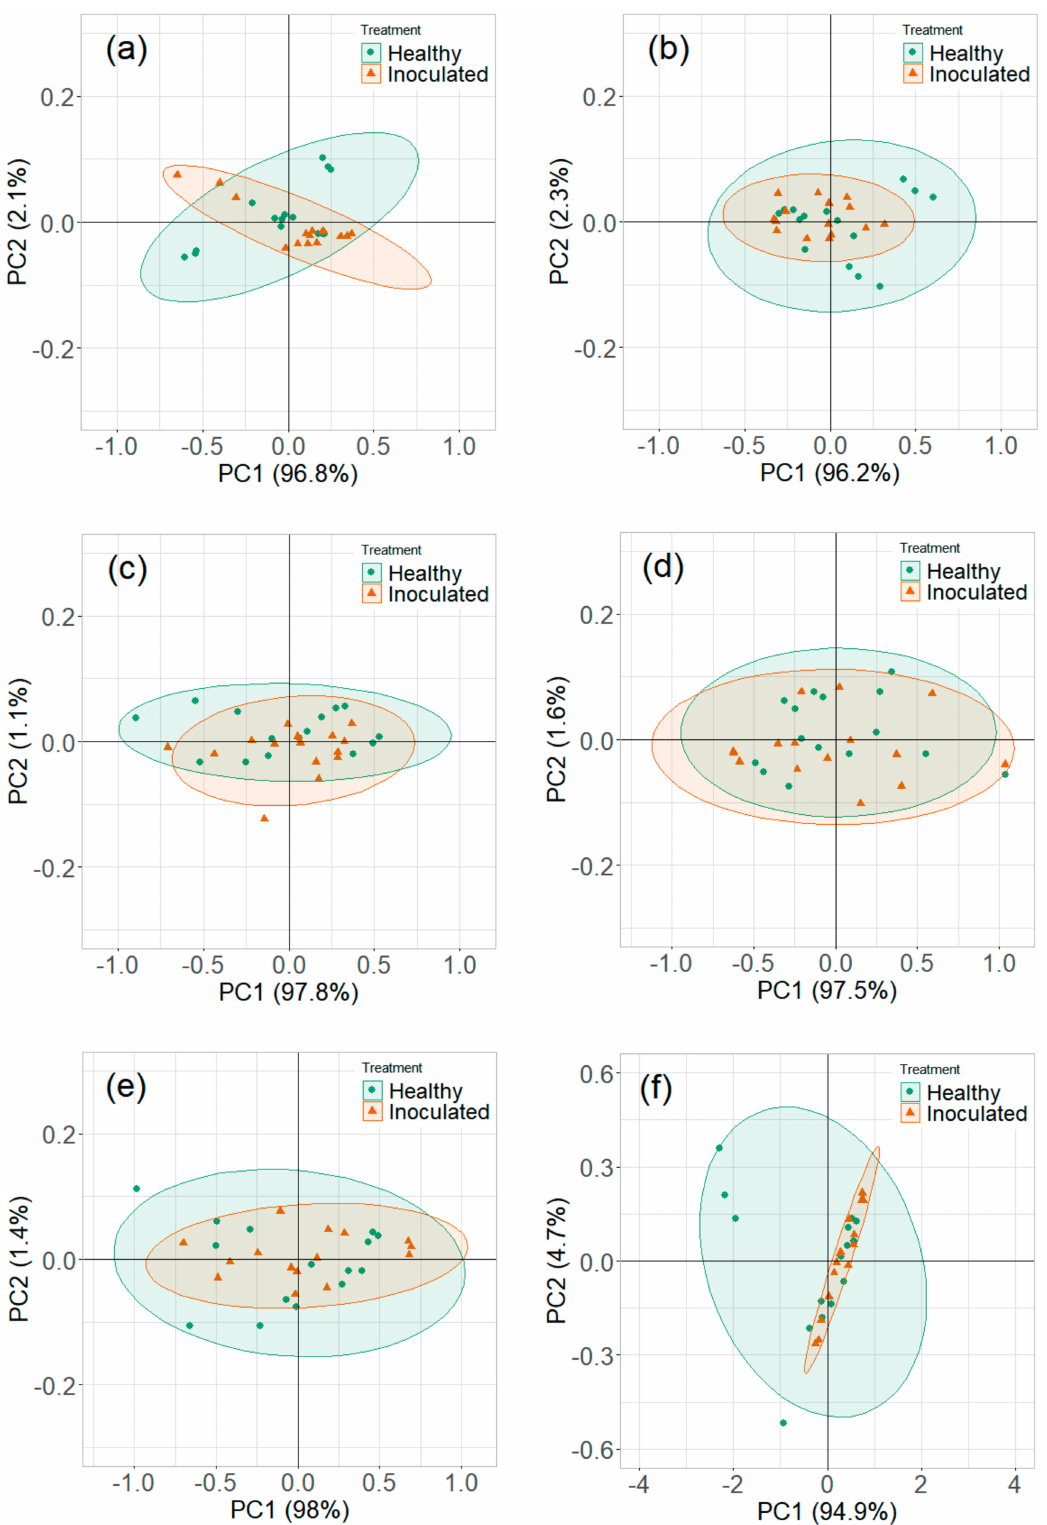
Figure 12. Principal component analysis plots for ion current of Ranger Russet tuber samples stored at reduced temperature (4 ◦ C, experiment-3) on ( a ) 0th, ( b ) 1st, ( c ) 5th, ( d ) 10th, ( e ) 15th, and ( f ) 31st days after